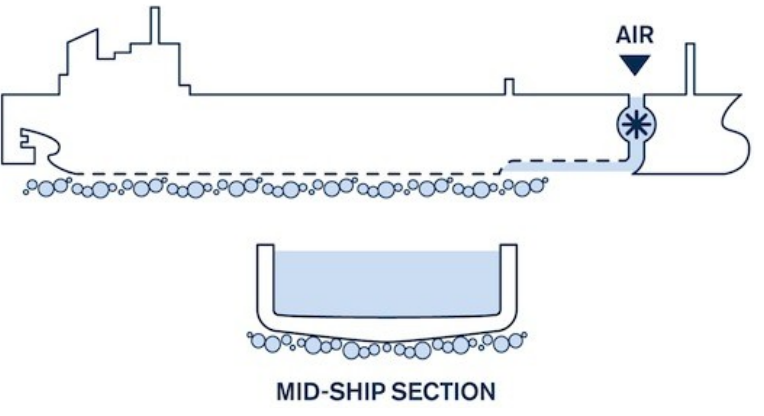
Figure 18. The air lubrication system leads [166–168]. (Copyright: DK Group).